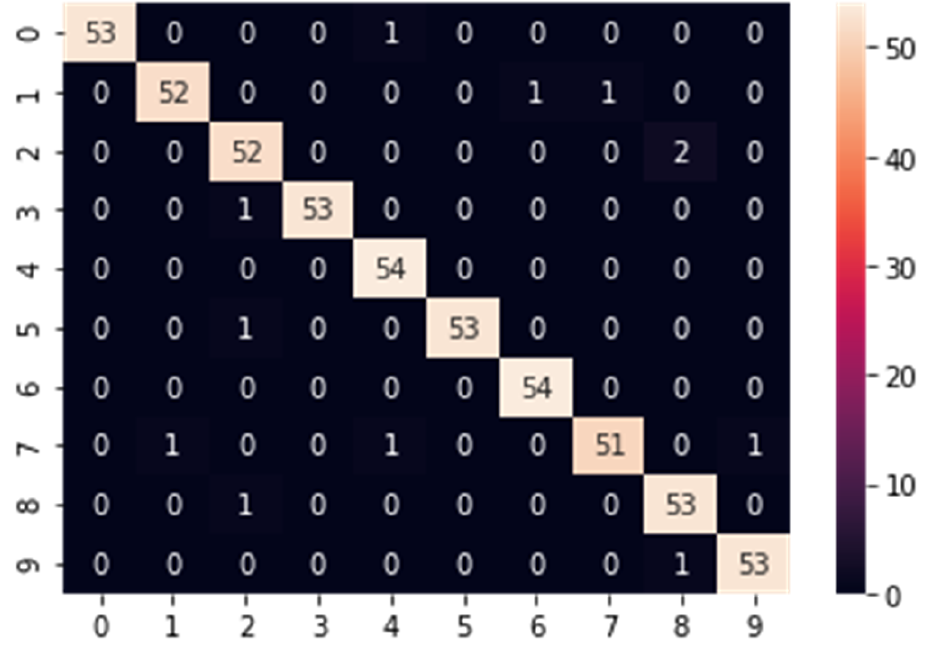
Figure 6. Confusion matrix of the proposed method.